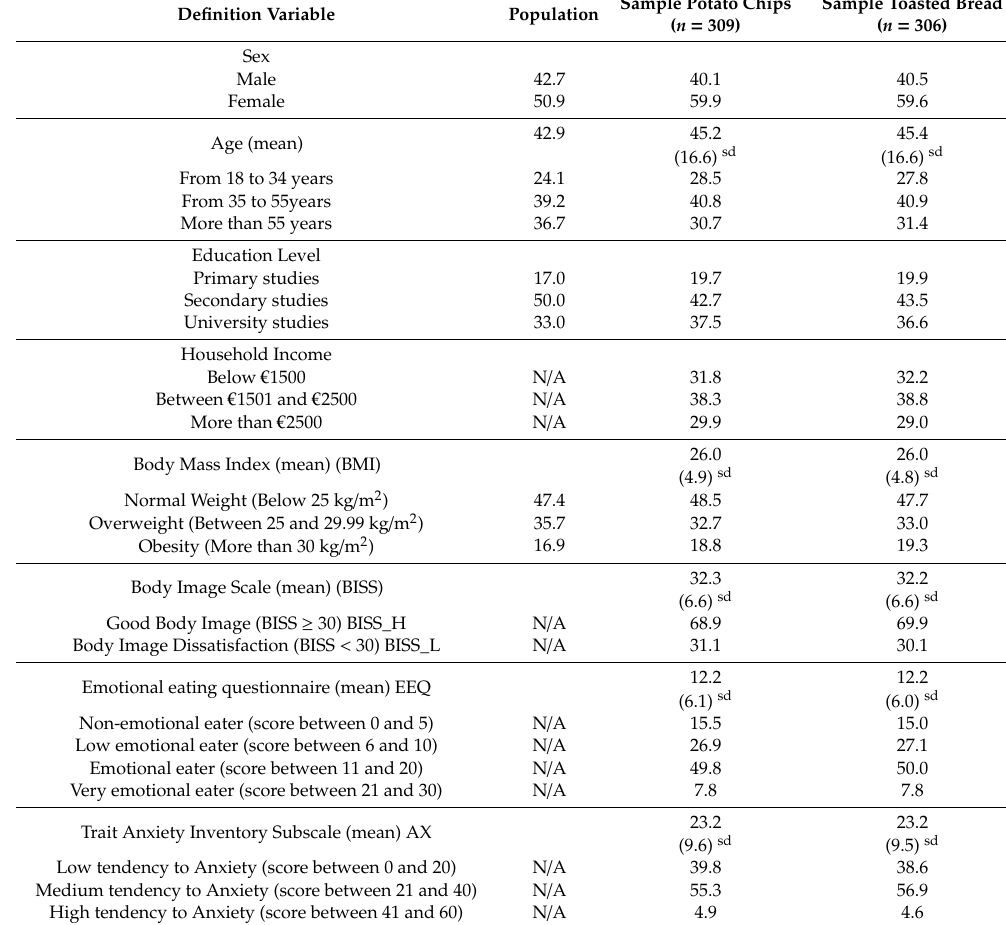
Table 2. Sample sociodemographic and psychological